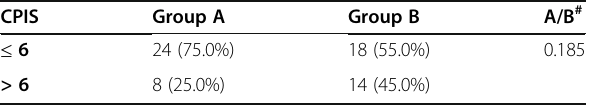
Table 4 Comparison between study groups as regards the CPIS score after treatment (clinical cure)